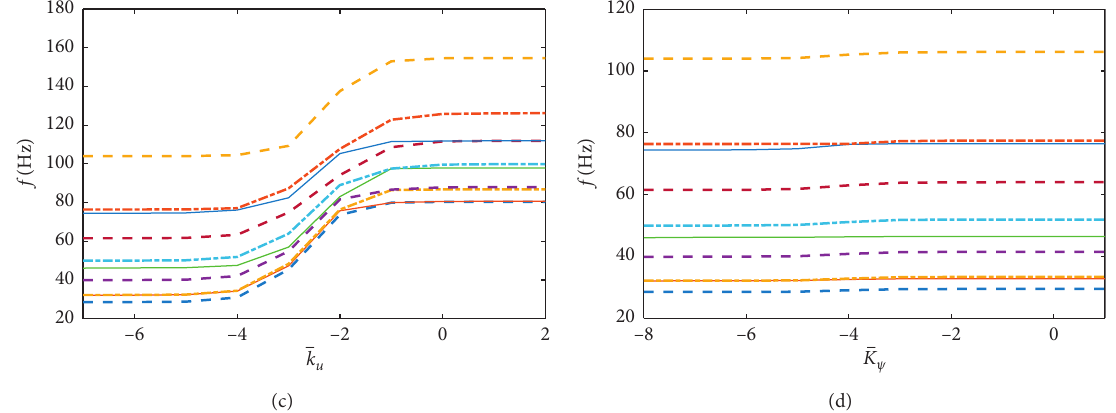
Figure 10: Frequency curves of the first 10 orders of conical shell with one displacement elastically restrained and the others free.